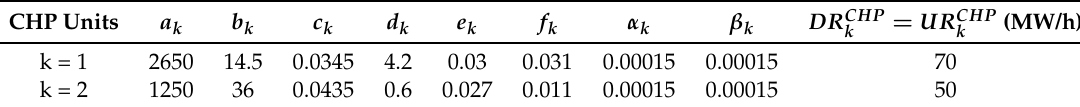
Table 2. Data of CHP Units.